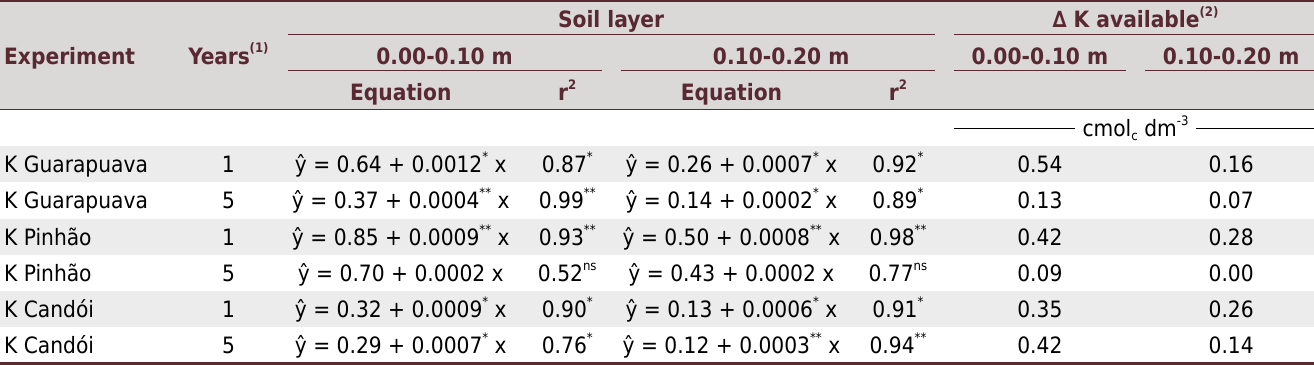
Table 4. Relationship between K 2 O rates applied and increase in available K in two soil layers of Humic Hapludox soils at different times after application in long-term no-tillage experiments